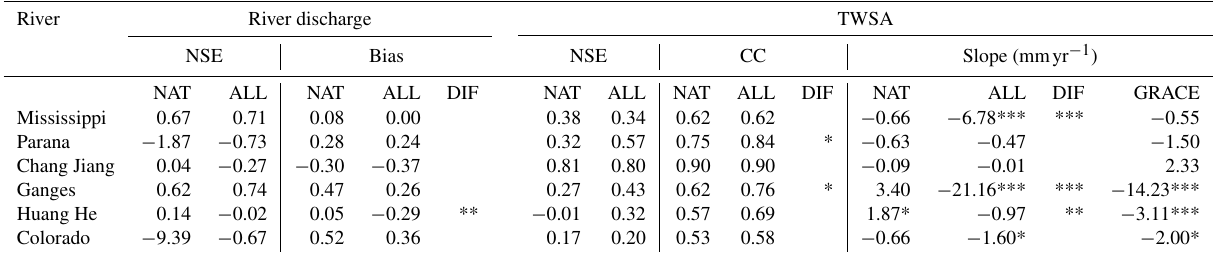
Table 4. River discharge and terrestrial water storage anomaly (TWSA) simulations for heavily human-affected basins. NSE and CC stand for Nash–Sutcliffe efficiency and correlation coefficient, respectively. Statistical test was performed for bias, CC, and slope.